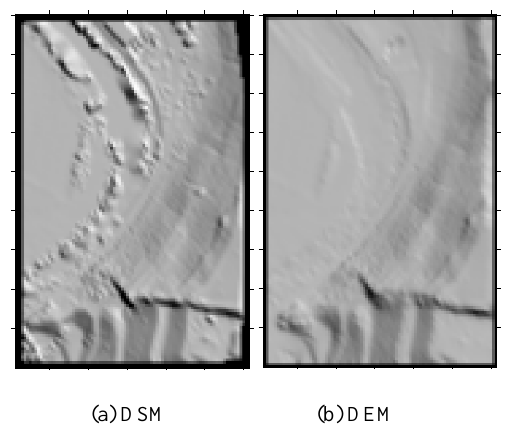
Figure 3. Filtering result of sample 52